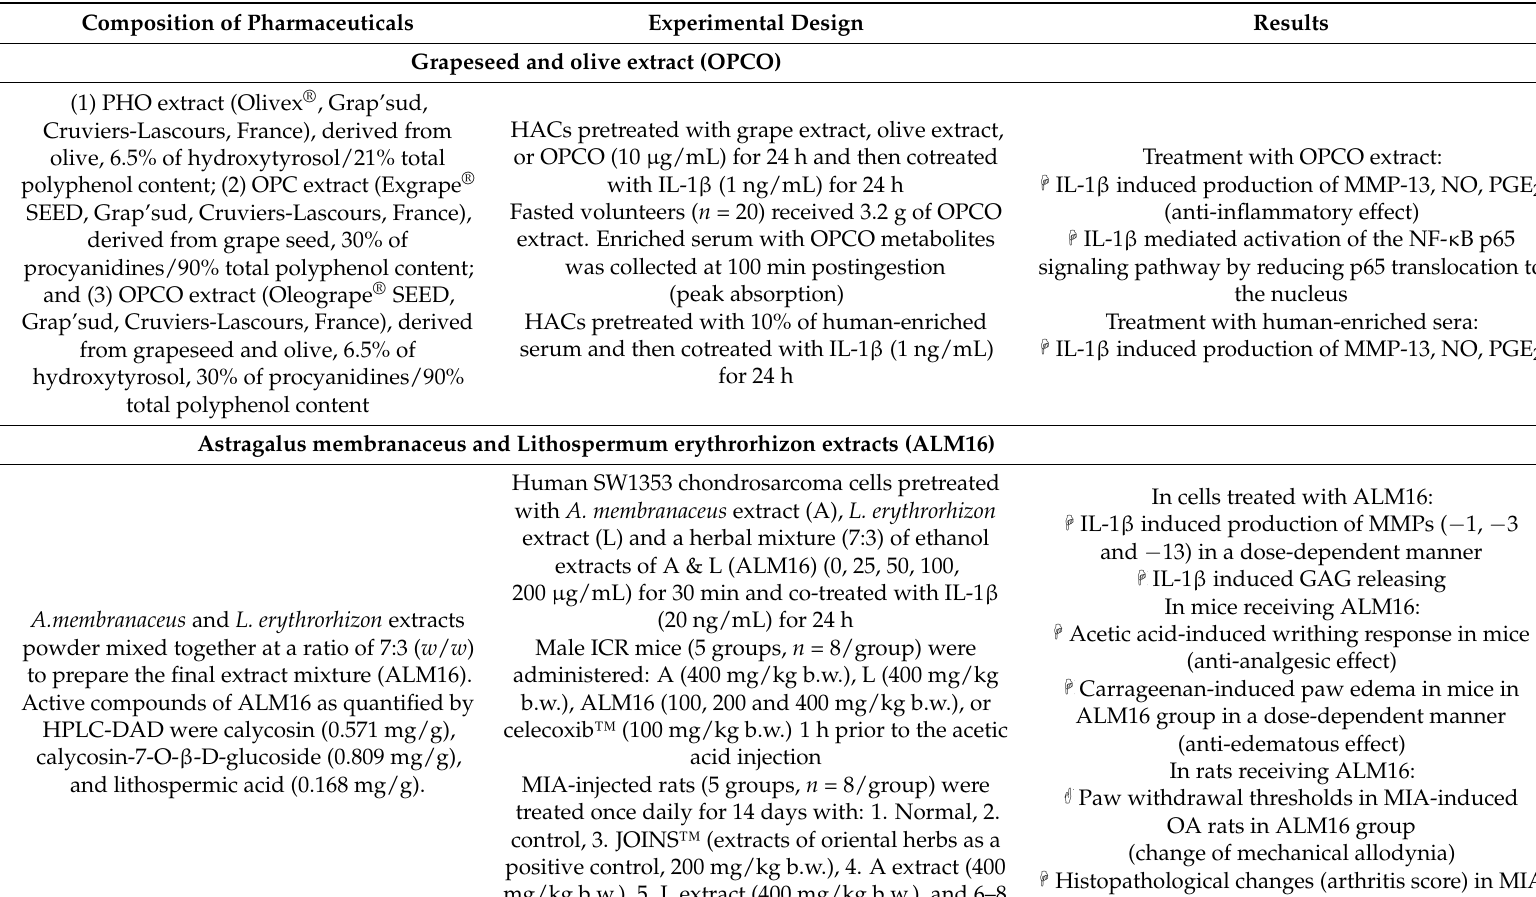
Table 1. Preclinical and clinical studies assessing the effect of synthetized extracts/polyphenols in osteoarthritis